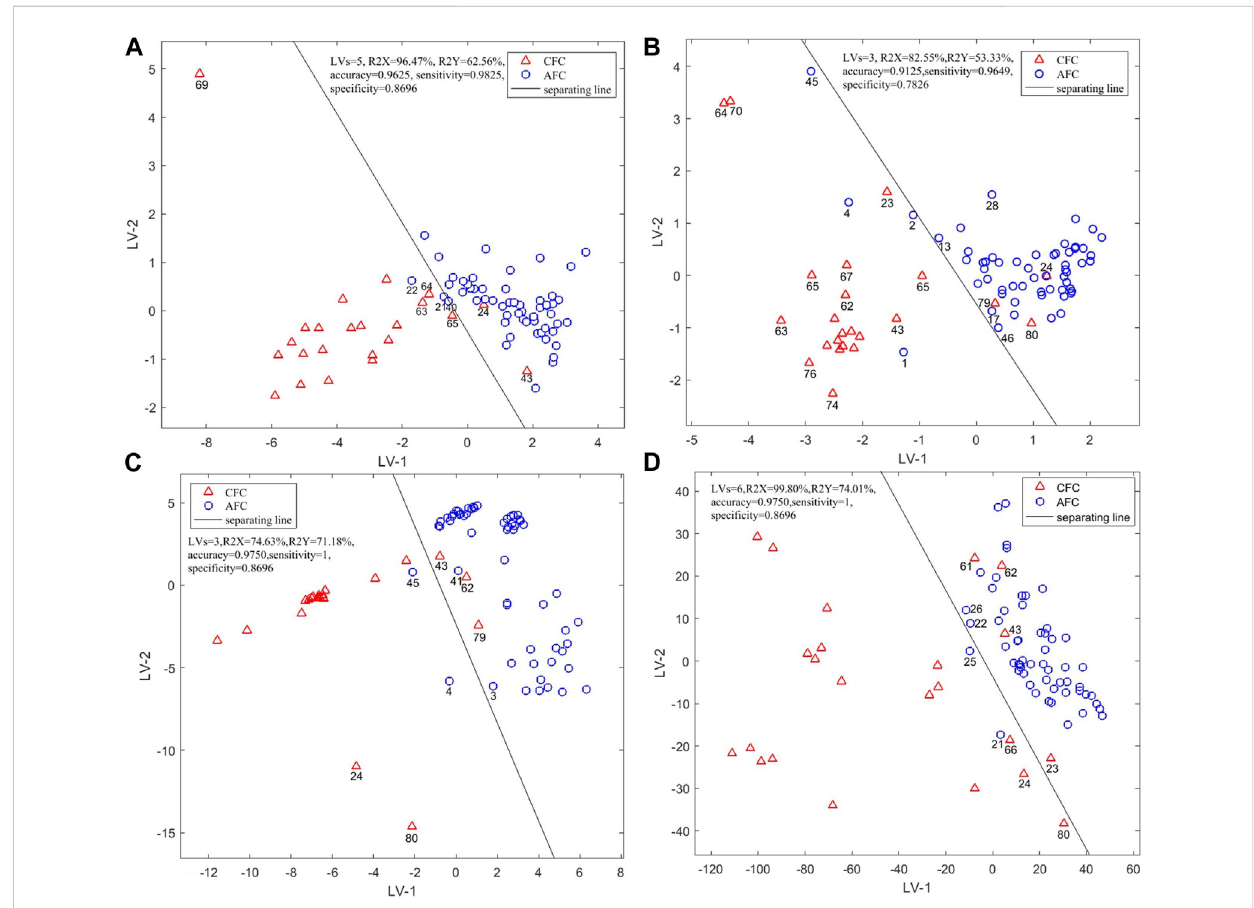
FIGURE 4 Scores Plot of Single-Source PLS-DA authenticity and counterfeit identi fi cation model based on (A) electronic nose, (B) electronic tongue, (C) electronic eye and (D) NIR spectra.